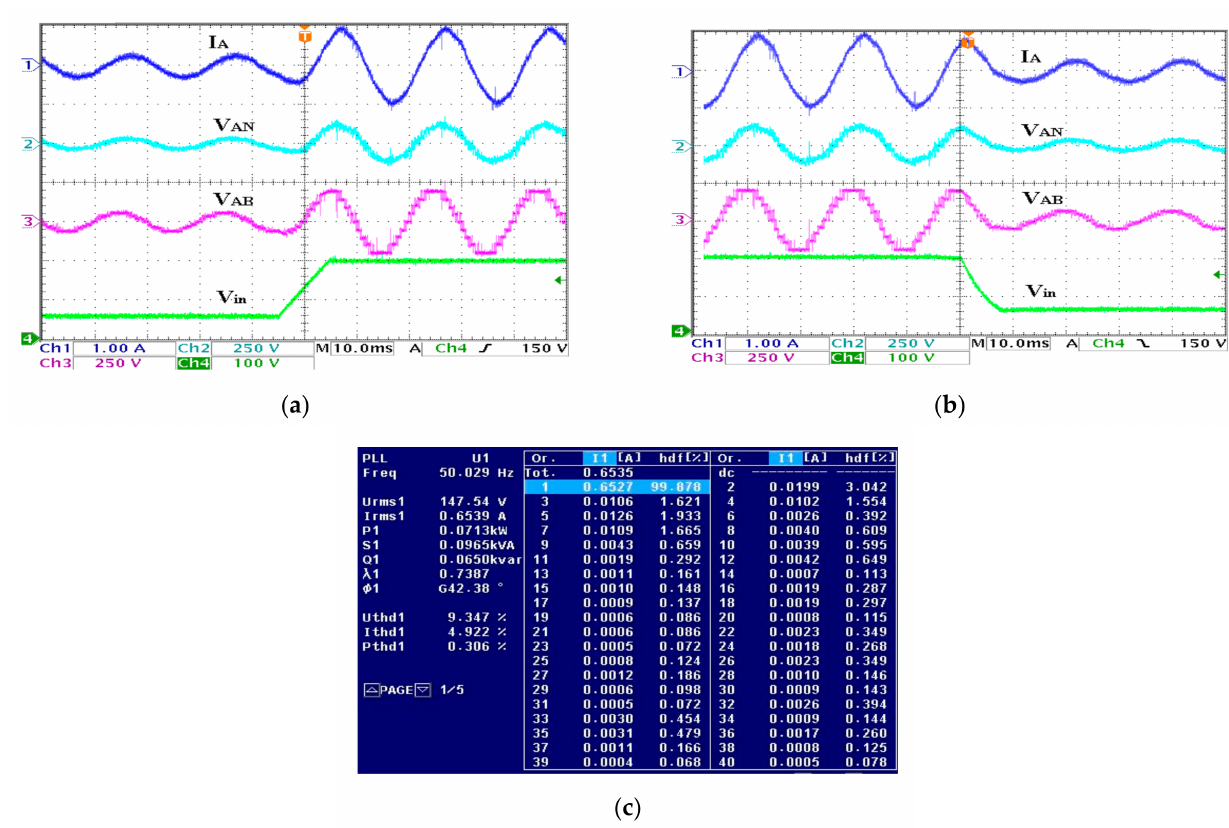
Figure 16. Experimental results of inverter’s waveforms (output current I A , phase voltage V AN , line-to-line voltage V AB and input voltage V in ) without online tuning for a step response with V in changes between 60 V and 200 V. ( a ) Step-up response, ( b ) step-down response, ( c ) output current